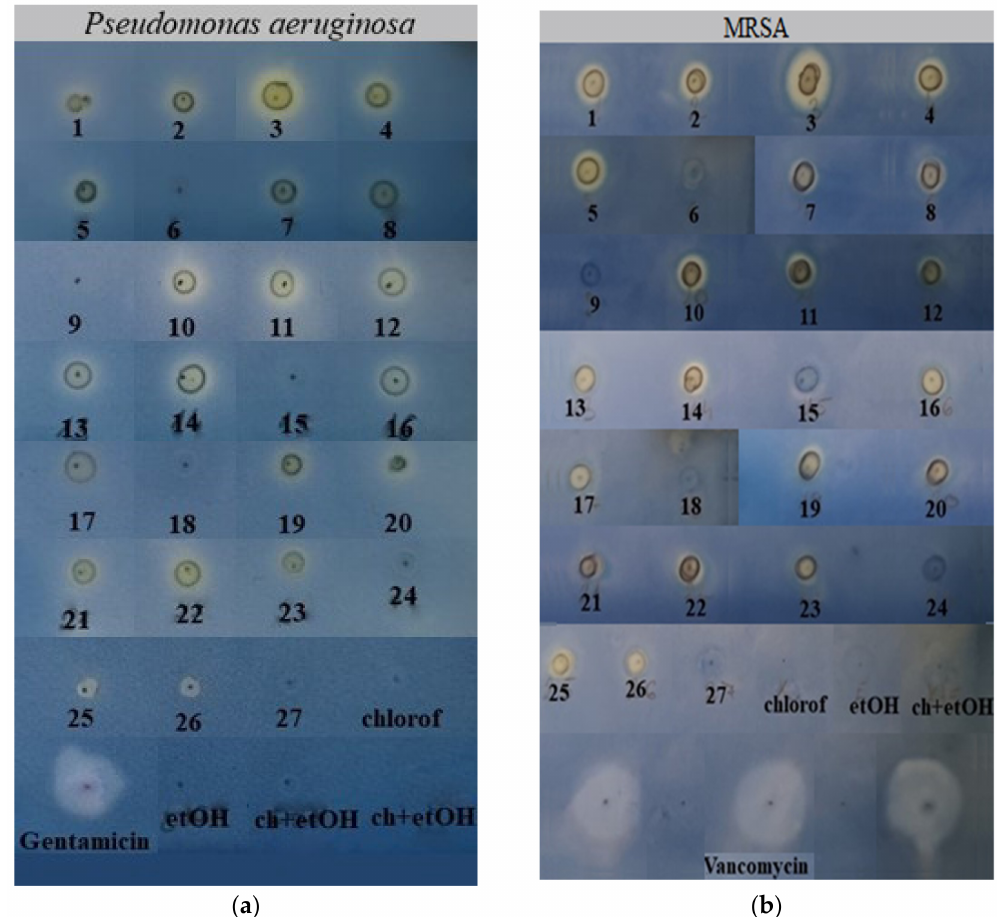
Figure 1. ( a ) Detection of the antibacterial activity of clary sage SC-CO 2 extracts, positive control (gentamicin), and solvents against P. aeruginosa by TLC-DB. The numbering of the samples is the same as that shown in Table 1; ( b ) Detection of the antibacterial activity of clary sage SC-CO 2 extracts, positive control (vancomycin), and solvents against MRSA by TLC-DB. The numbering of the samples is the same as that shown in Table